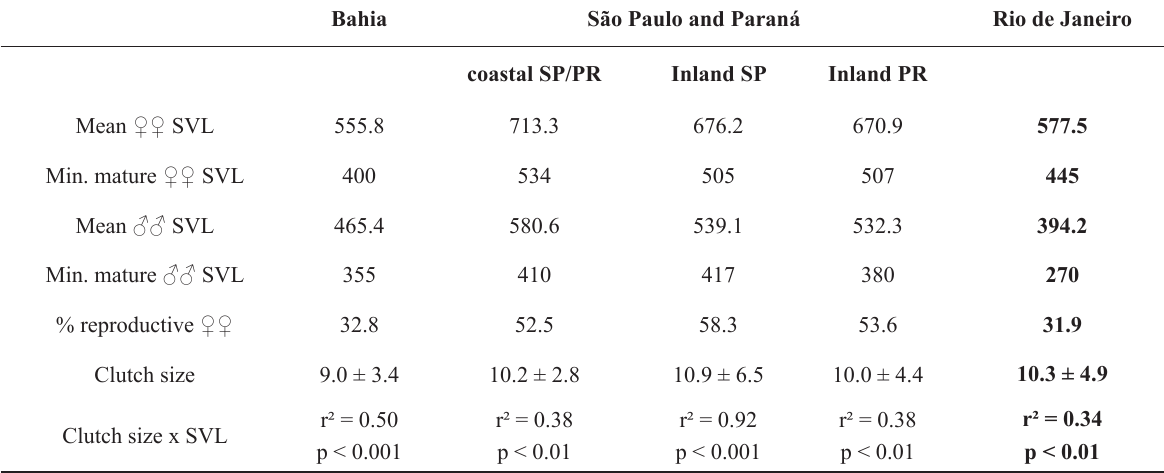
Mean and minimum SVL (in mm) of sexually mature males and females, percentage of reproductive females in the sample, and clutch size and its relationship to female SVL in Erythrolamprus miliaris from Rio de Janeiro State (data from present study, in bold) and from populations from other Brazilian states (data from Pizzatto and Marques